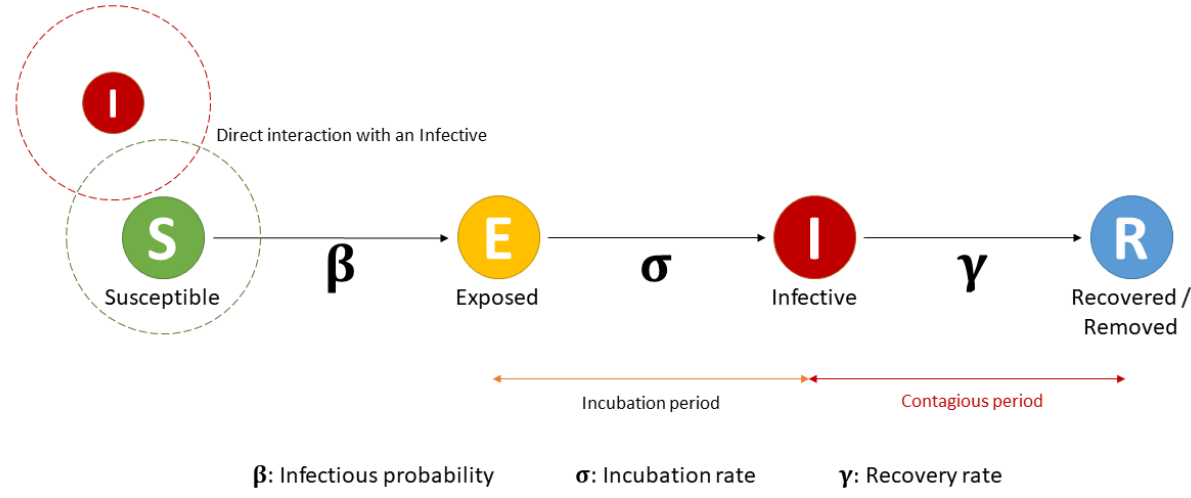
Figure 5. SEIR evolution based on parameters.